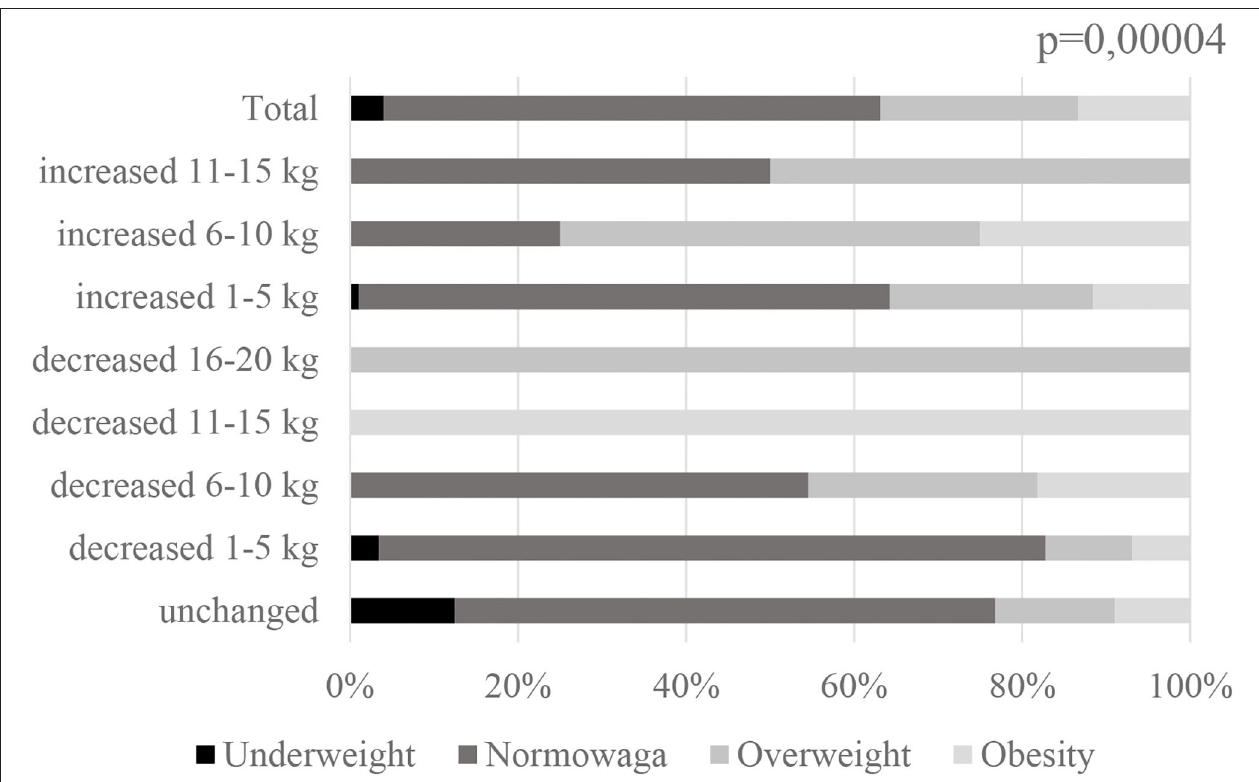
FIGURE 2 | Change in body weight during lockdown vs. current body weight among subjects n = 225.